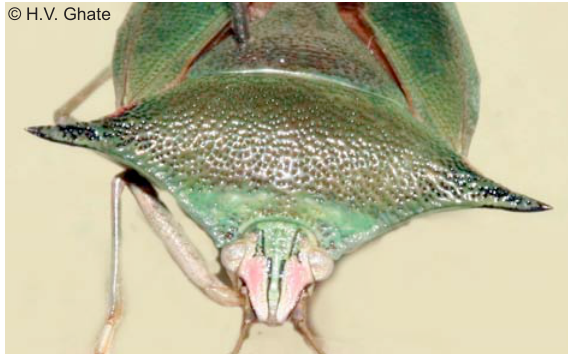
Image 8b. Frontal view of Sabaeus humeralis showing details of